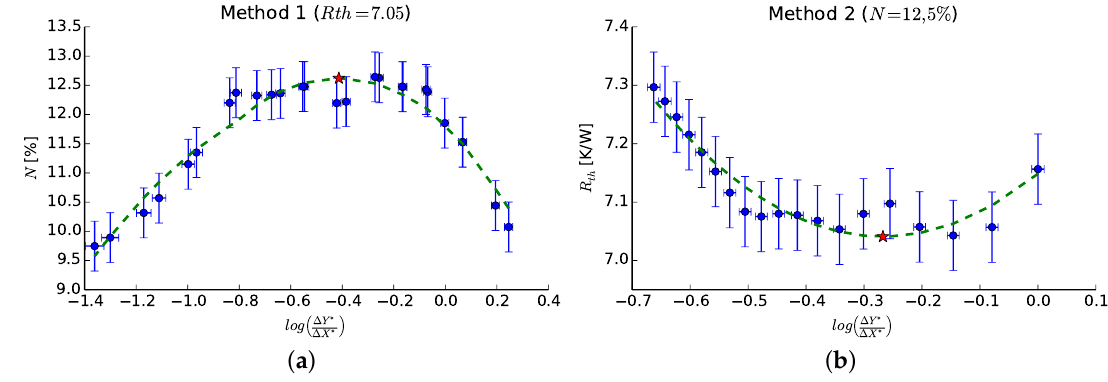
Figure 7. ( a ) Heat source density along an isoline for a constant thermal resistance; and ( b ) the thermal resistance along the corresponding isoline for the density. Optima are indicated by the red stars.